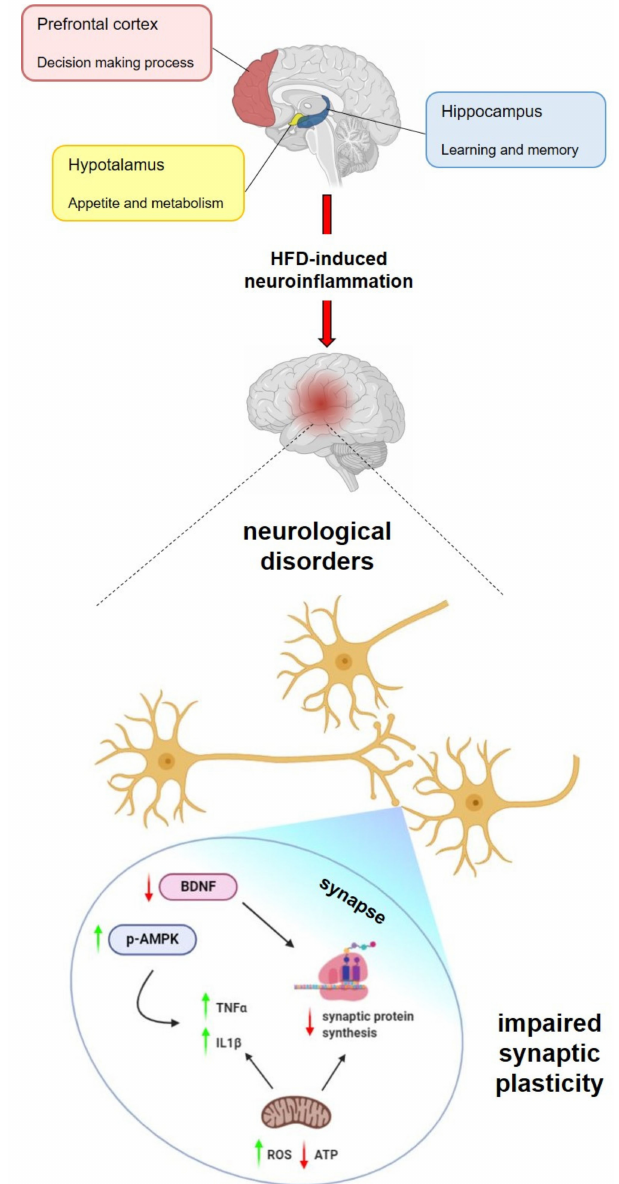
Figure 4. Overnutrition-induced neuroinflammation: molecular mechanisms. The overnutrition- induced neuroinflammation directly a ff ects the hypothalamus (controlling appetite and metabolism), hippocampus (involved in learning and memory) and prefrontal cortex (playing a crucial role in decision making processes) and contributes to neurological disorders. The negative e ff ects of high fat diet (HFD) is more pronounced in the synaptic region of the neuron leading to impaired synaptic plasticity. AMPK and Brain-derived neurotrophic factor (BDNF) mediate the interplay between energetic impairment and synaptic integrity. In the synapse, BDNF and altered mitochondrial functions may contribute to a diminished local protein synthesis. The red arrows indicate decrease, and the green arrows indicate